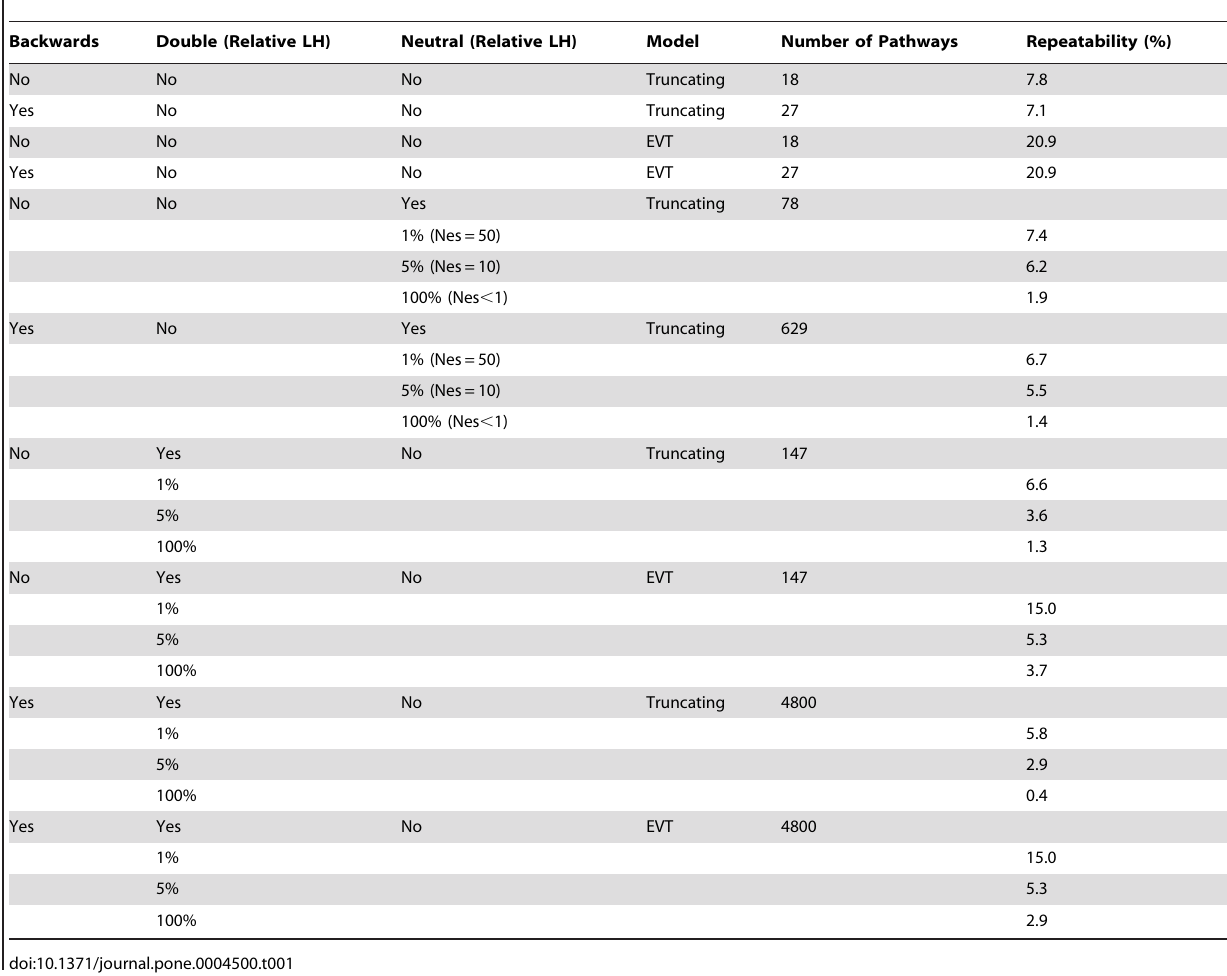
Table 1. Numbers of pathways and path repeatability under different conditions.